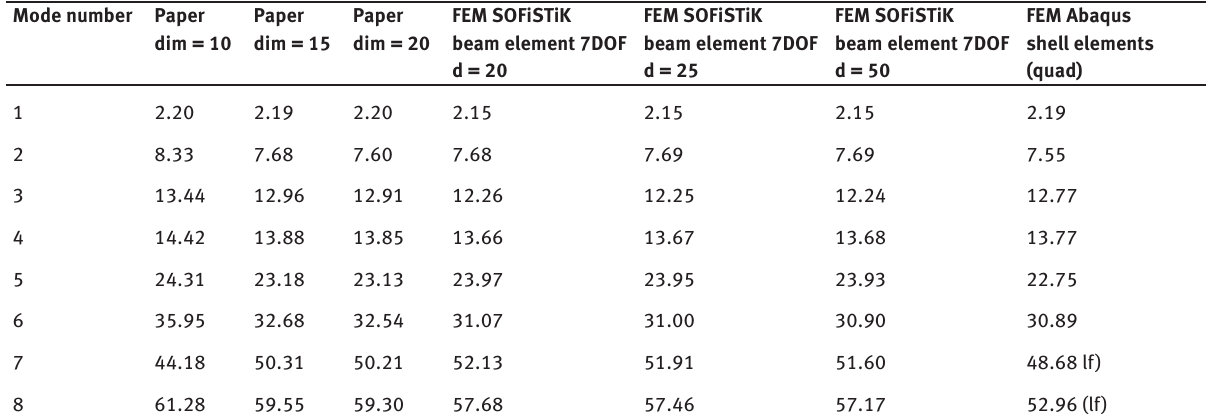
Table 2: Eigenfrequencies in case of clamped-free support (C-F) [Hz]. Mode number Paper